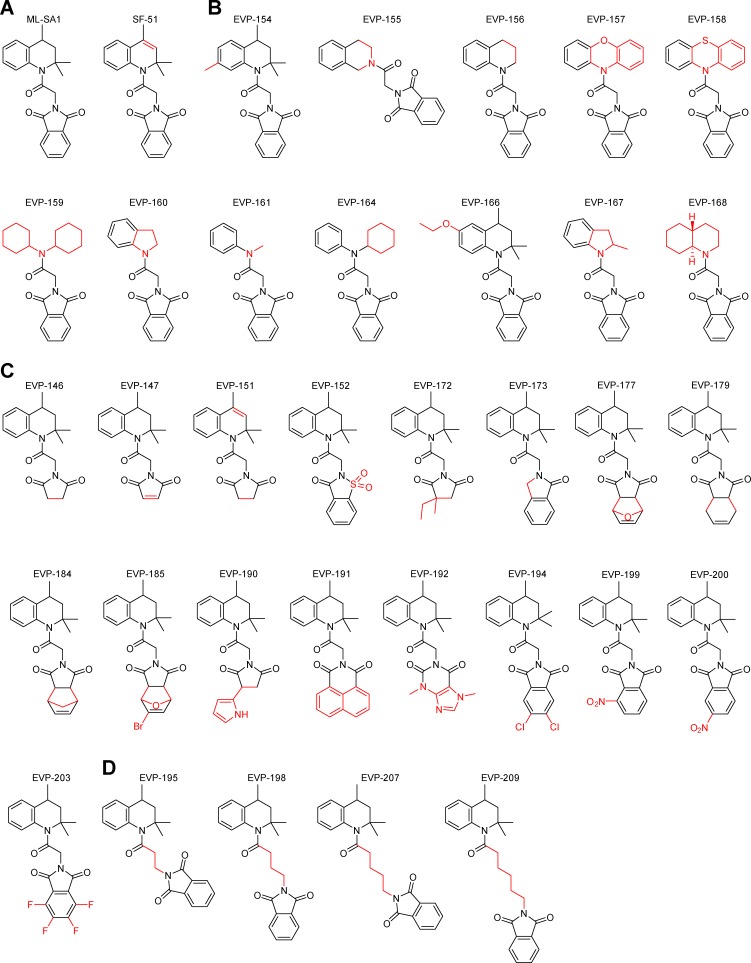
Structures of SF-51/ML-SA1 analogues.Shown are the chemical structures of all generated SF-51/ML-SA1 analogous compounds. Changes in comparison to SF-51/ML-SA1 are highlighted in red. (A) Structure of the lead compounds ML-SA1 and SF-51. (B) Modifications of the acetone anile residue. (C) Modifications of the phthalimide residue. (D) Modifications of the length of the acyl spacer.